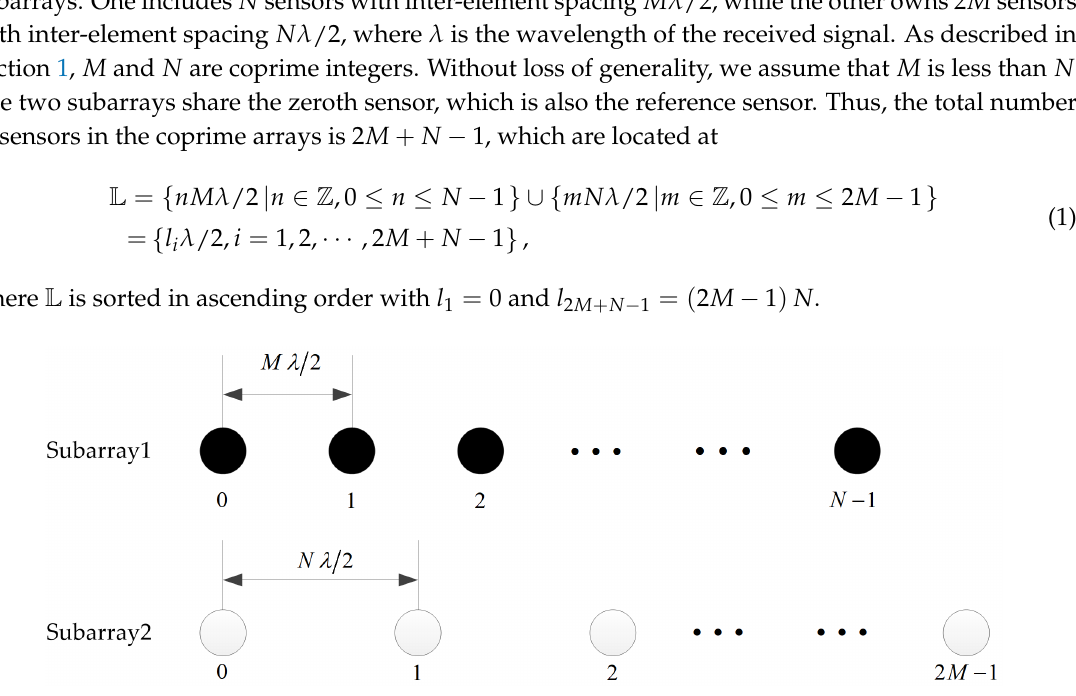
Figure 1. The geometry of the two subarrays in the coprime